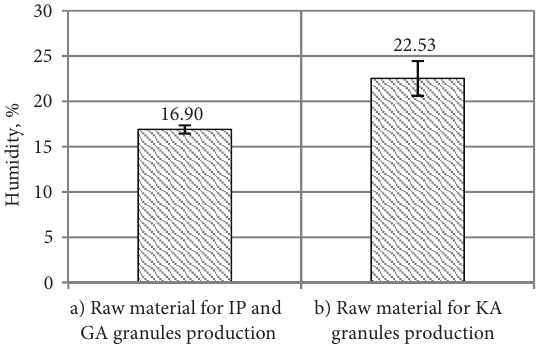
industrial and experimental granules a) Raw material for industrial pellets (IP) production and b) Raw material for experimental pellets (KA) production